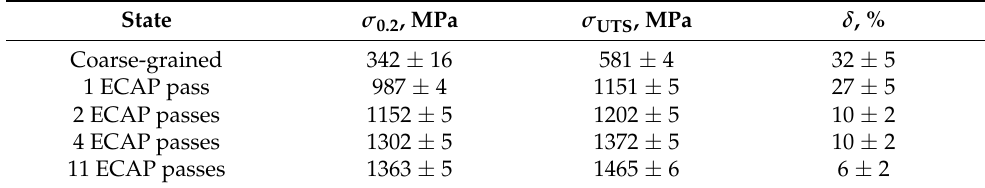
Figure 5. Engineering “stress–strain” curves of the TWIP steel before and after multi-pass ECAP. Table 1. Mechanical properties of the TWIP steel in different structural